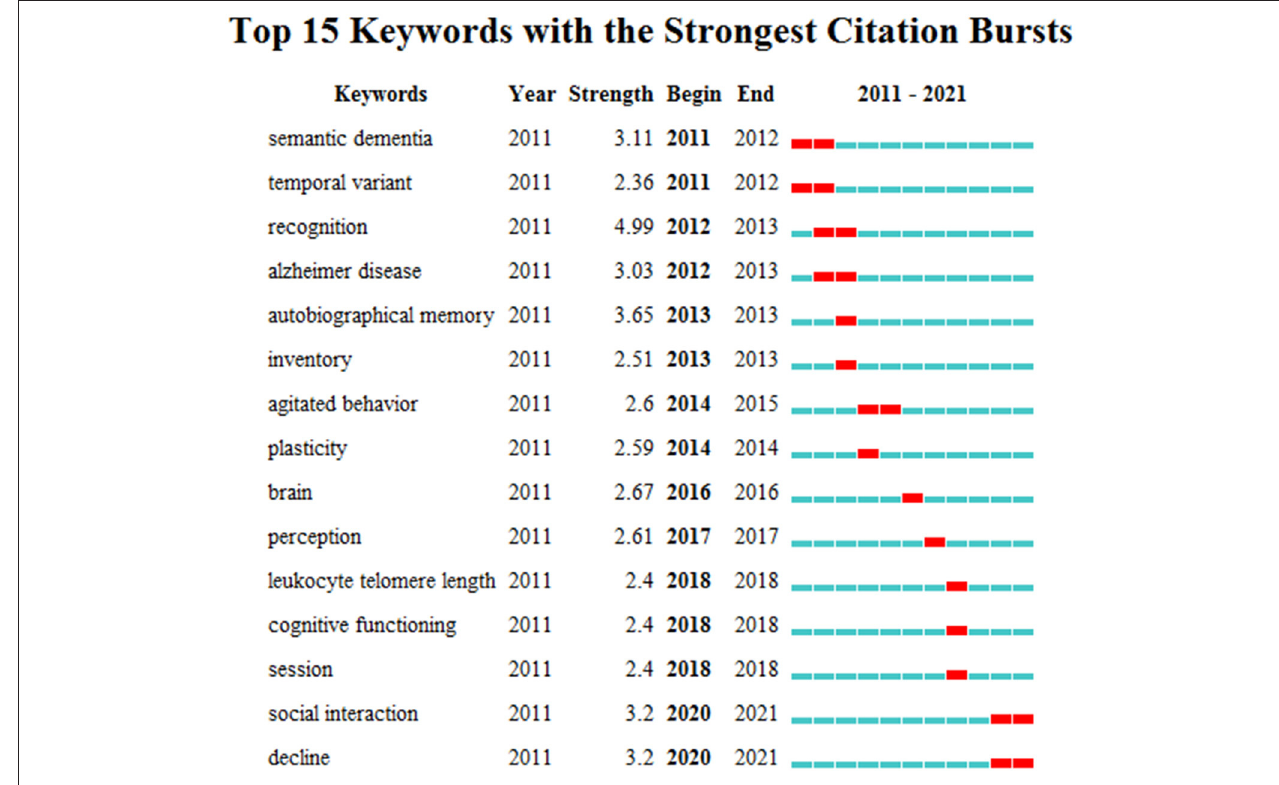
FIGURE 7 | Top 15 keywords with the strongest citation bursts.